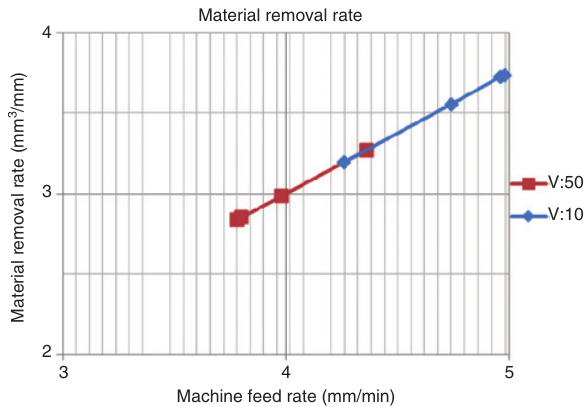
Figure 11 Result on material removal rate at different machine feed rate.